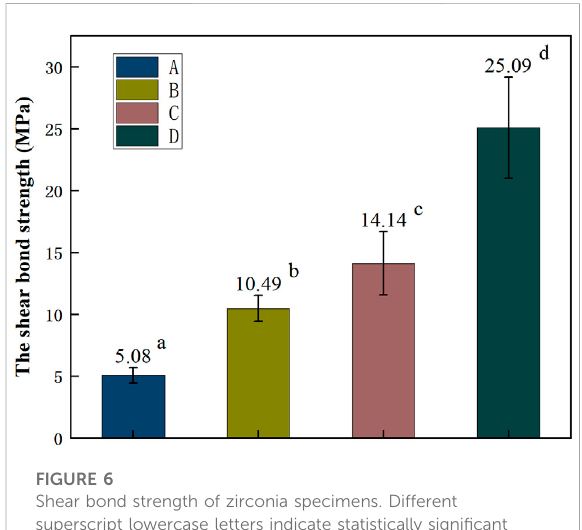
FIGURE 6 Shear bond strength of zirconia specimens. Different superscript lowercase letters indicate statistically signi fi cant differences ( p < 0.05).